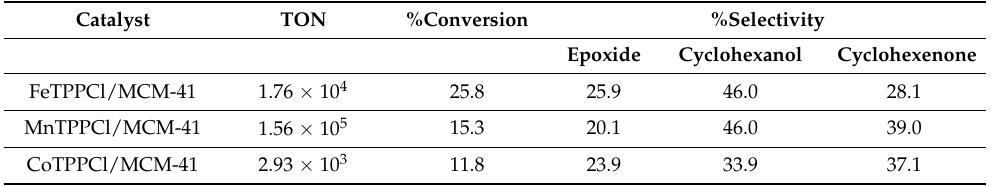
Table 1. Oxidation products of cyclohexene using porphyrins with different metals immobilized on